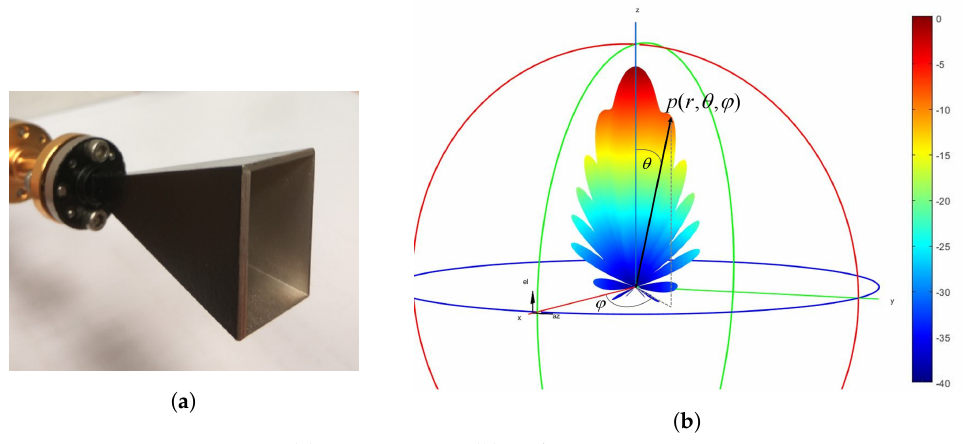
Figure 11. ( a ) Horn antenna. ( b ) Radiation pattern in 3D